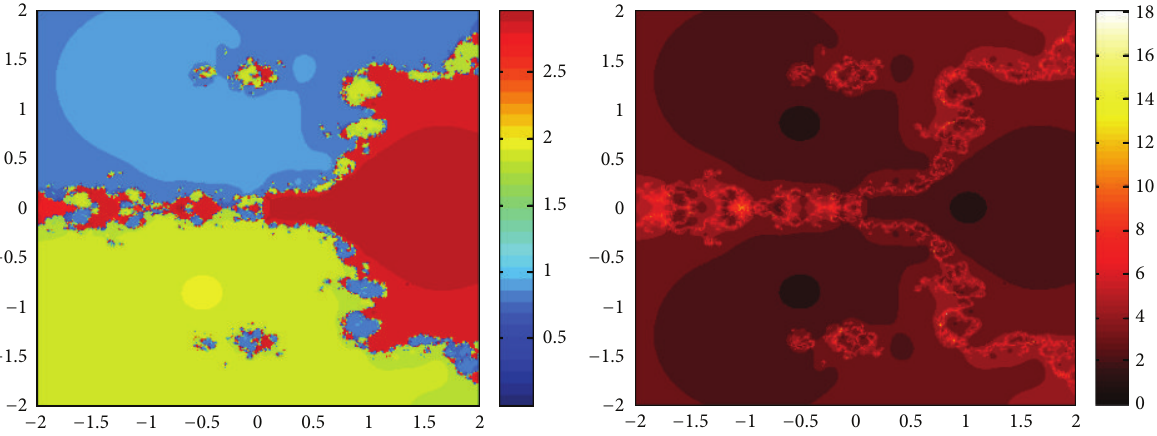
Figure 3: Basins of attraction of method (32) for 𝑝 3 (𝑥) .